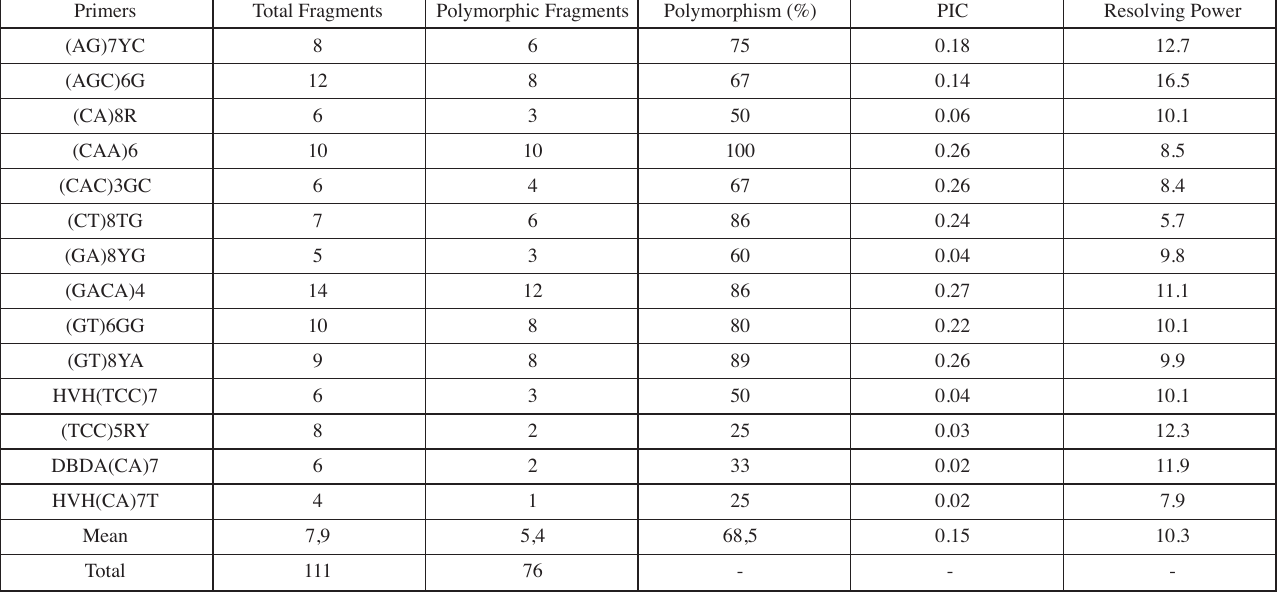
Tab. 2: Results on ISSR primers used for apple accessions